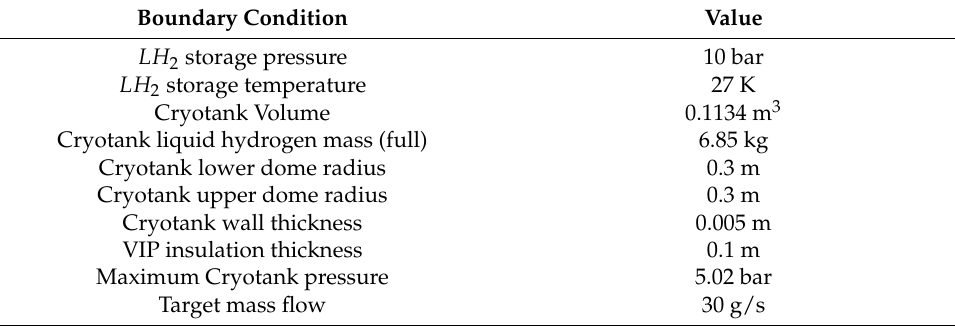
Table 1. Selected boundary conditions of the Fuelling Model.